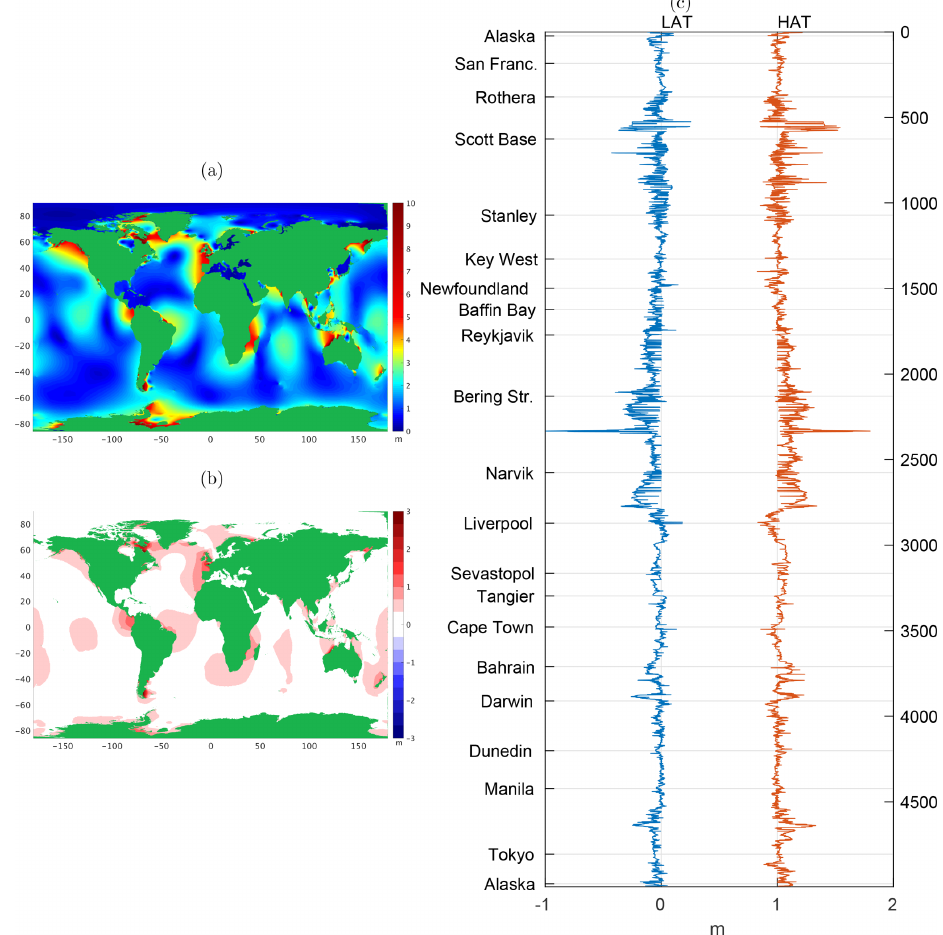
Figure 6. (a) Range calculated from maximum and minimum of 18.6-year prediction at 15min intervals from 26 primary and 8 related constituents and nodal modulations derived from 1-month tide-only GTSM. (b) Difference between (a) and 2 ( M 2 + S 2 + O 1 + K 1 ) from the same run. (c) Change in metres along the coast of predicted LAT (blue) and HAT (red, offset 1m) between e M t and e M s (tide only or tide and surge). Tides derived from 62 constituents from GTSM 2013. See Appendix A for an explanation of coastal